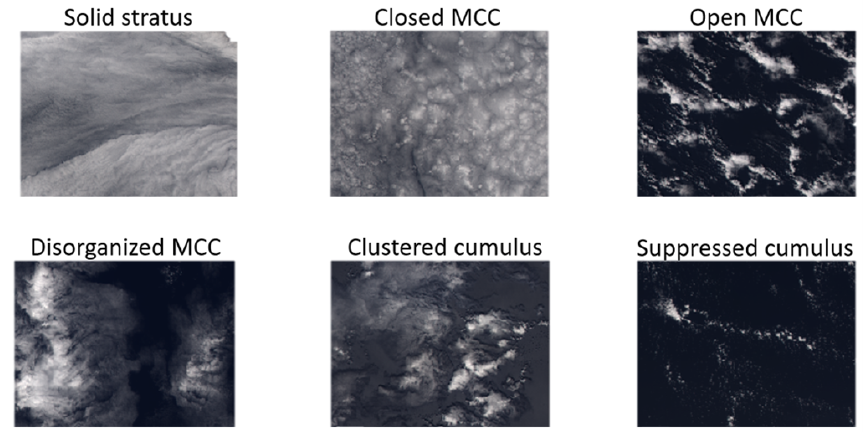
Figure 2. Typical examples of scenes belonging to each of our classification categories. Image scale is roughly 100km across. Images are captured using NASA